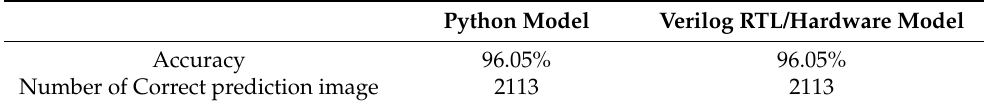
Table 1. Comparison of Python and RTL test accuracy in